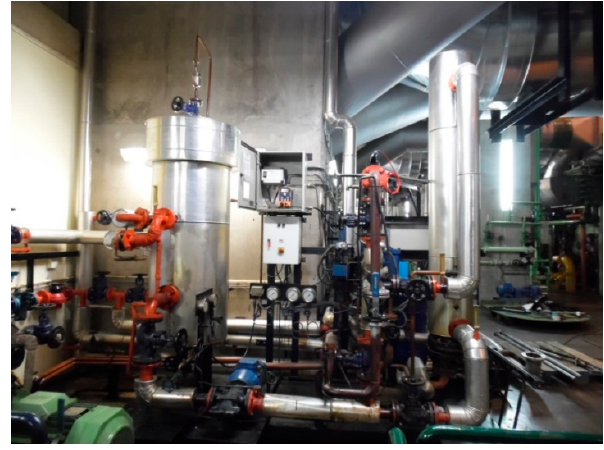
Figure 6. Fuel intake circuit including mixing tank, fuel pump, vertical heater and filter. The fuel of the four-stroke diesel engines in the thermoelectric power plant is fuel oil with 1% sulphur. The specifications of the fuel are described in Table 1. Table 1. Fuel load specifications.